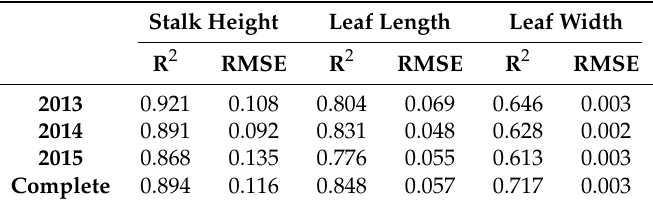
Table 2. Accuracy analysis of the stochastic inversion of PCE EM metamodel given with the calculated R 2 and root-mean-square error (RMSE) values for the years 2013, 2014, 2015 and the complete dataset. Stalk Height Leaf Length Leaf Width R 2 RMSE R 2 RMSE R